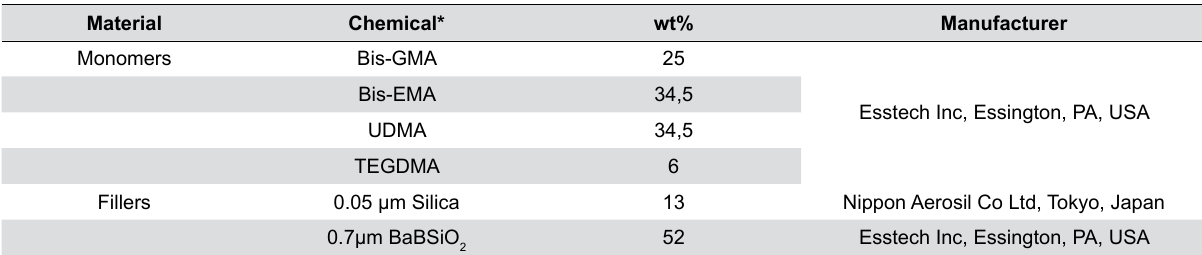
Table 1- Experimental composites composition